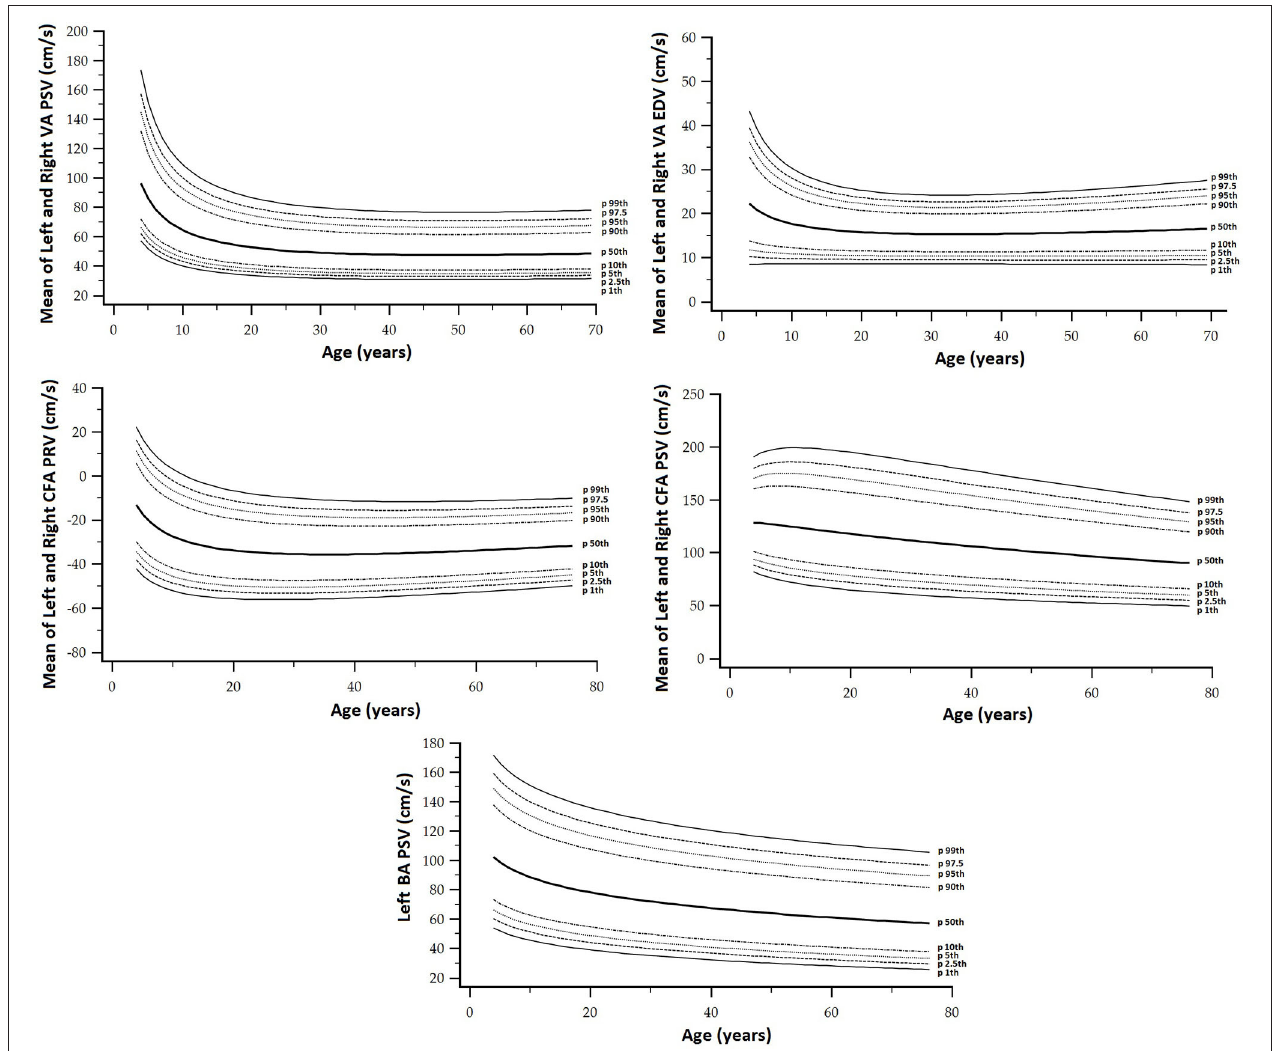
FIGURE 5 | CCA, ICA, and ECA and PSV ratio (PSVR), and St Mary ratio (SMR) age-related percentile